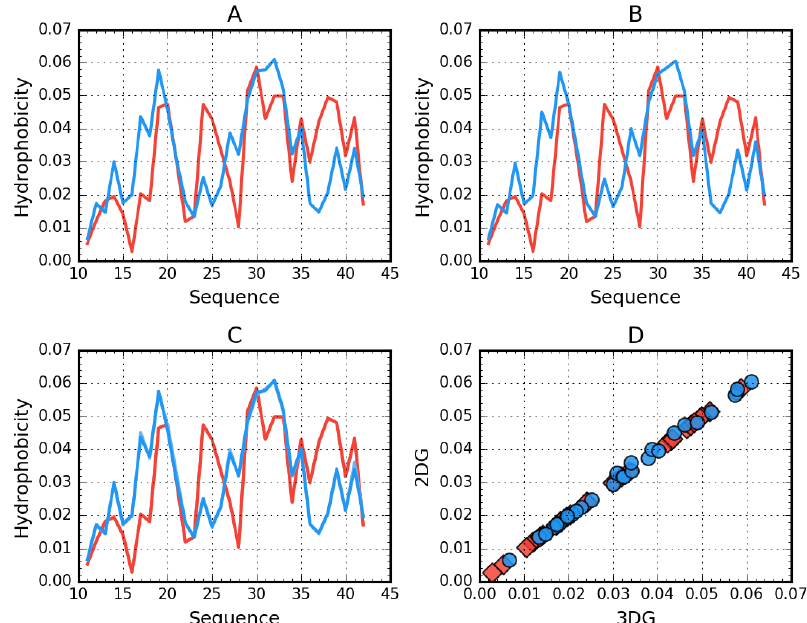
Figure 2. Theoretical (T, blue) and observed (O, red) hydrophobicity density profiles for A β (11–42) (2MXU). A —3DG. B —2DG. C —3DG (darker lines) vs. 2DG (lighter lines) T and O distribution comparison—line plot (di ff erences are indistinguishable at this zoom level). D —3DG vs 2DG T (blue circles) and O (red rhombuses) distribution comparison—scatter plot.